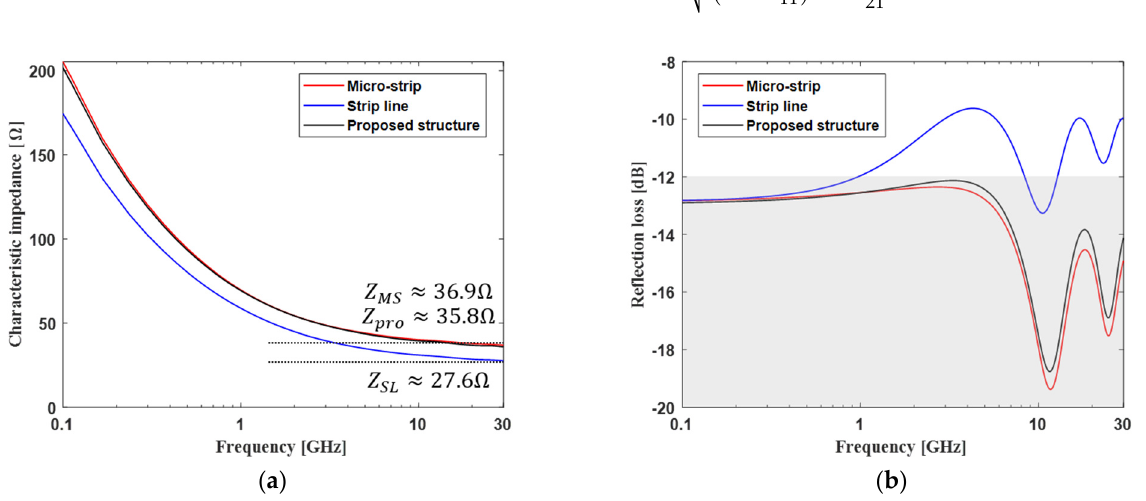
Figure 11. Impedance analysis of the proposed channel structure and conventional channel structure: ( a ) characteristic impedance and ( b ) reflection loss.